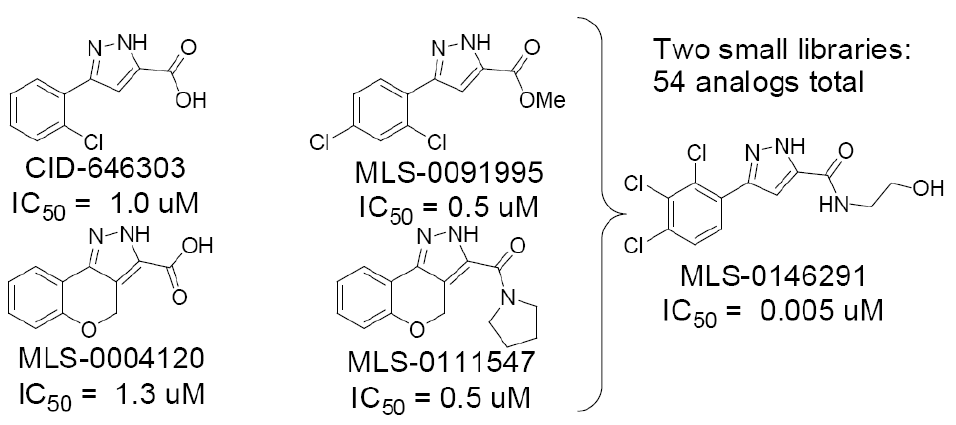
Figure 6 . Summary of CID-646303 series